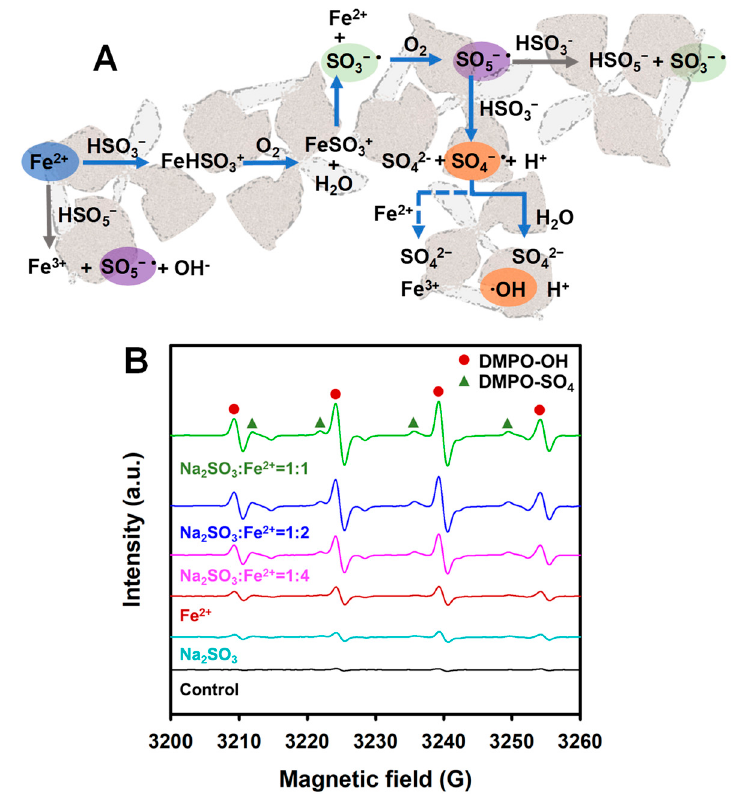
Figure 5. Schematic approach for the chain reactions ( A ) and EPR spectra ( B ) of Fe(II)/S(IV) oxida- tion system. oxidation